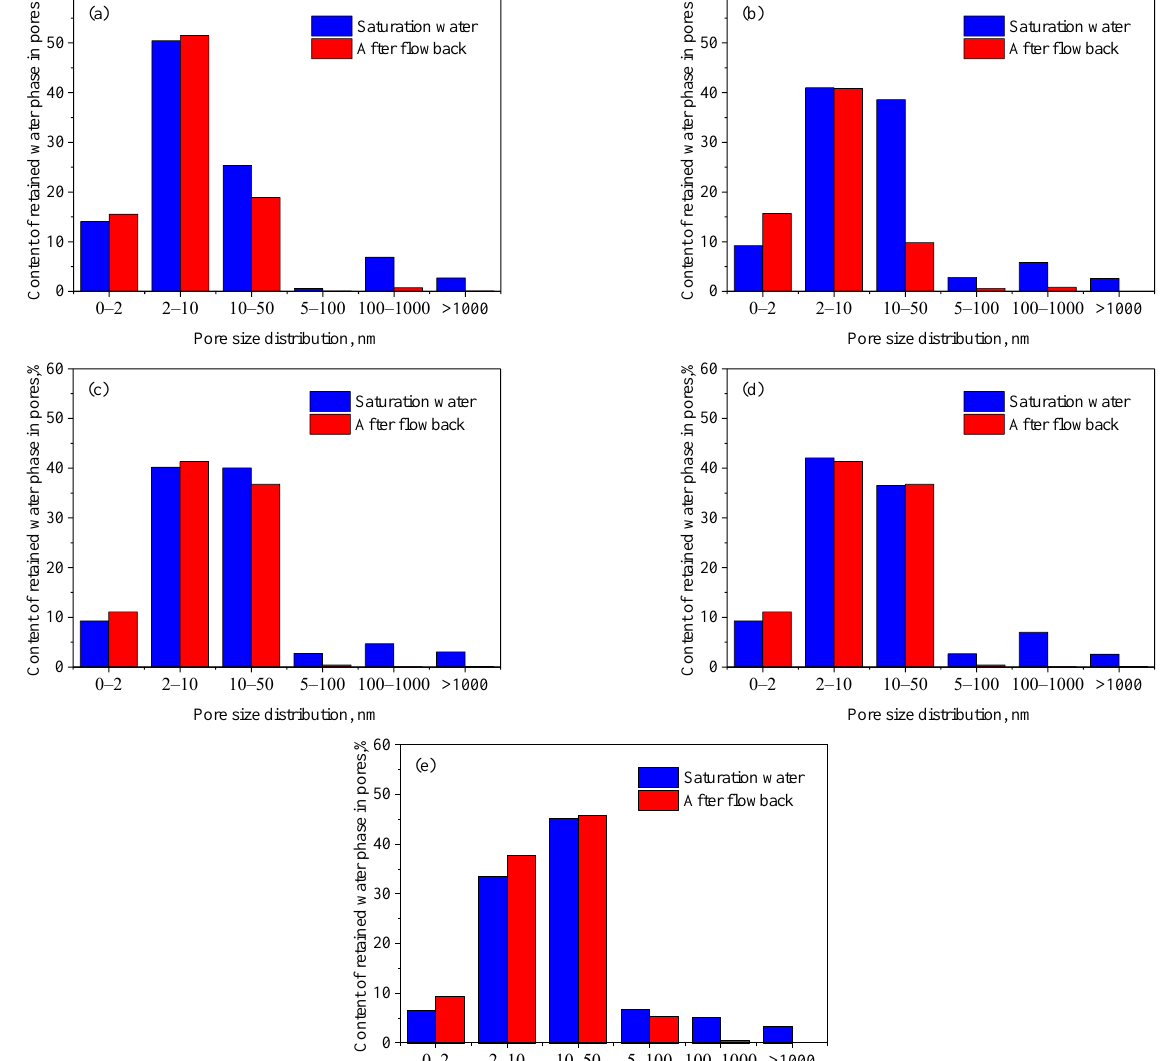
Figure 10. Distribution of saturated water and water phase after flowback in multiscale pores and fractures of shale samples ( a – e , respectively, correspond to samples WY-1~WY-5; The water content in the pore of 2~10 nm after flowback remains unchanged or slightly increases. The water content in the pore space of 10~50 nm decreases or remains